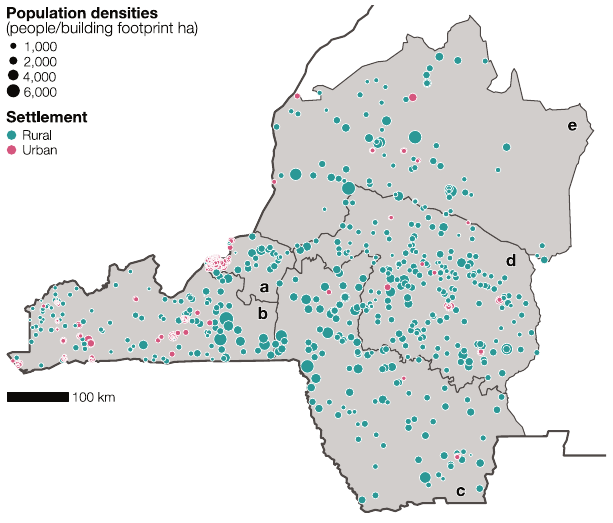
Fig. 2 Microcensus clusters location and associated population densities. Observed population densities (people/building footprint ha) across the microcensus clusters ( n = 905 clusters) in the provinces of ( a ) Kinshasa ( n = 26 rural and n = 254 urban clusters), ( b ) Kongo Central ( n = 113 rural and n = 109 urban clusters), ( c ) Kwango ( n = 111 rural and n = 6 urban clusters), ( d ) Kwilu ( n = 182 rural and n = 23 urban clusters), and ( e ) Mai- Ndombe ( n = 69 rural and n = 12 urban clusters). The microcensus clusters are classi fi ed according to the settlement type (urban in pink and rural in turquoise).